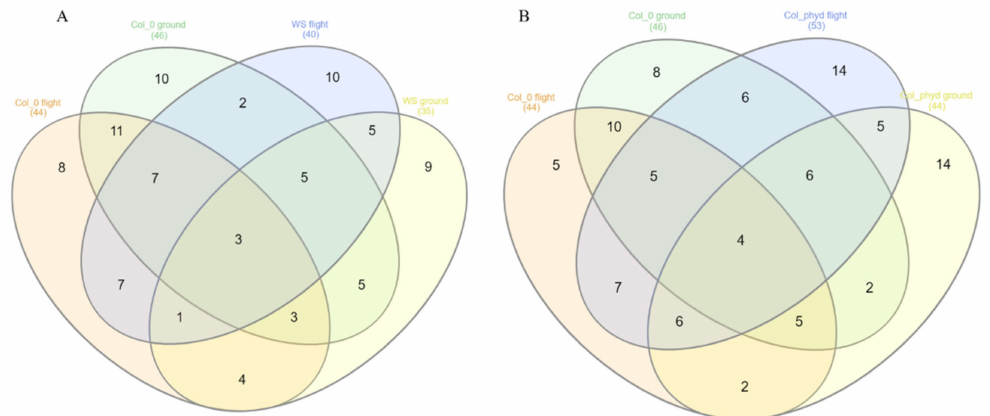
Figure 5. Venn diagrams showing the number of shared hub genes from the gene regulatory networks for Arabidopsis thaliana . ( A ) Between the WS and Col-0 ecotypes in spaceflight and ground control for both total light and dark environ- ments. ( B ) Between Col-0 ecotype and Col-0 mutant phyD in spaceflight and ground control for both total light and dark environments.